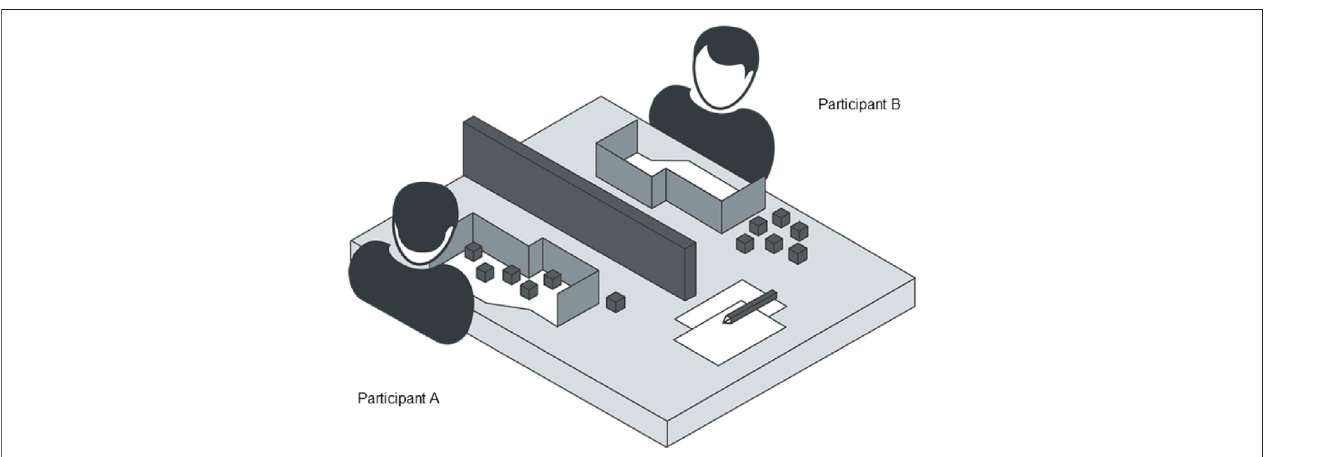
FIGURE1| Schematicoverviewoftheexperimental setup.View (A) showsaside-view:twoparticipantssittingacrossfromeach otheratatable,withalowbarrier betweenthem.Participantscaneasilyseeeachother,buttheviewoftheotherperson ’ sworkspaceisobscuredbythebarrier.View (B) showsthetablefromabove:two identical room layouts. Participant A has fi ve items placed in the room, one distractor object outside of the room. For participant B, all six items are placed on the side of theroom.Penandpaperareplacedtotheleft-handsideofthePWA(incaseofneglect,hemianopiaorhemiparesis),andisprovidedforbothparticipants.Abutton at theend ofthetable(againtotheleftofthePWA)isusedtoindicate completion ofthetask.Alowbarrier(black bar)blockstheviewoftheotherperson ’ sroom,butnot the view of their pen and paper.